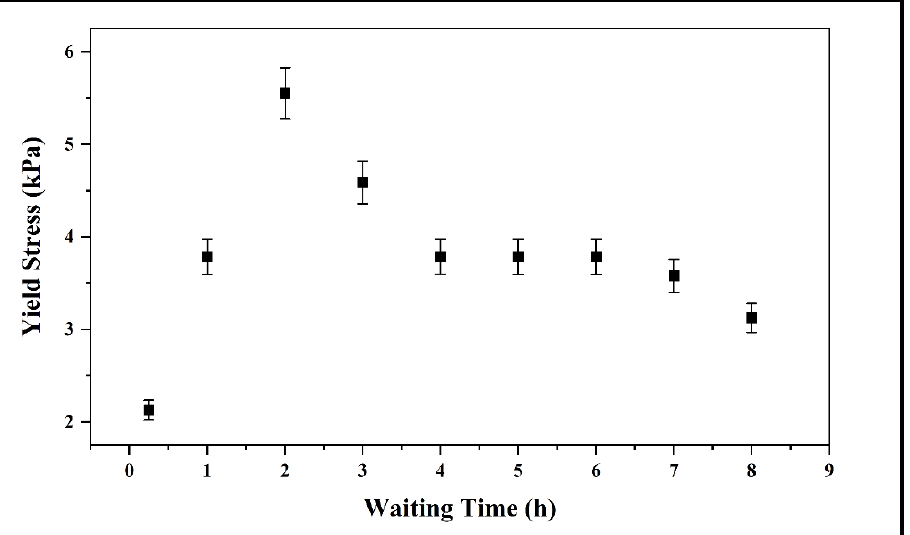
Figure 9. Yield stress data obtained from the stress sweep from 0.1 Pa to 10 4 Pa at different levels of waiting time.